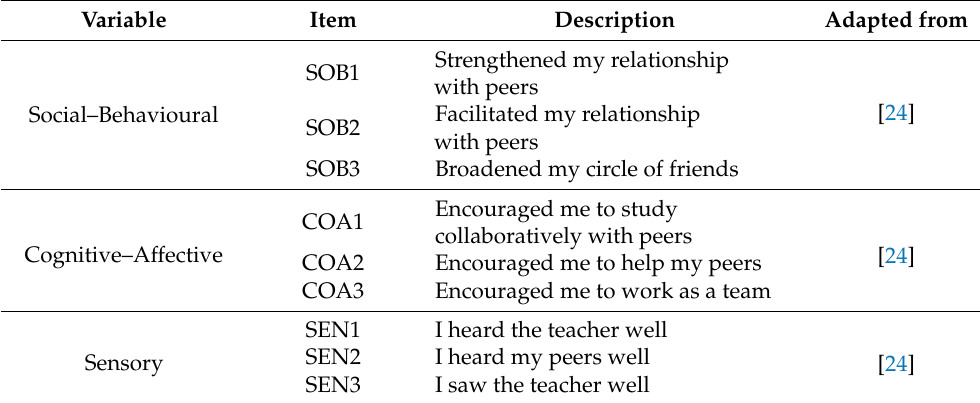
Table 1. Variables and items used in survey.